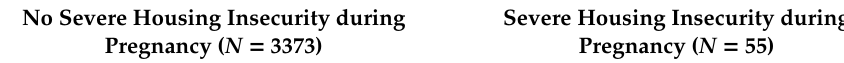
Table 1. Characteristics of mothers and infants who did vs. did not experience housing insecurity during pregnancy Ϯ ( N = 3428 mother–infant dyads), the Fragile Families and Child Wellbeing Study, 1998–2000.